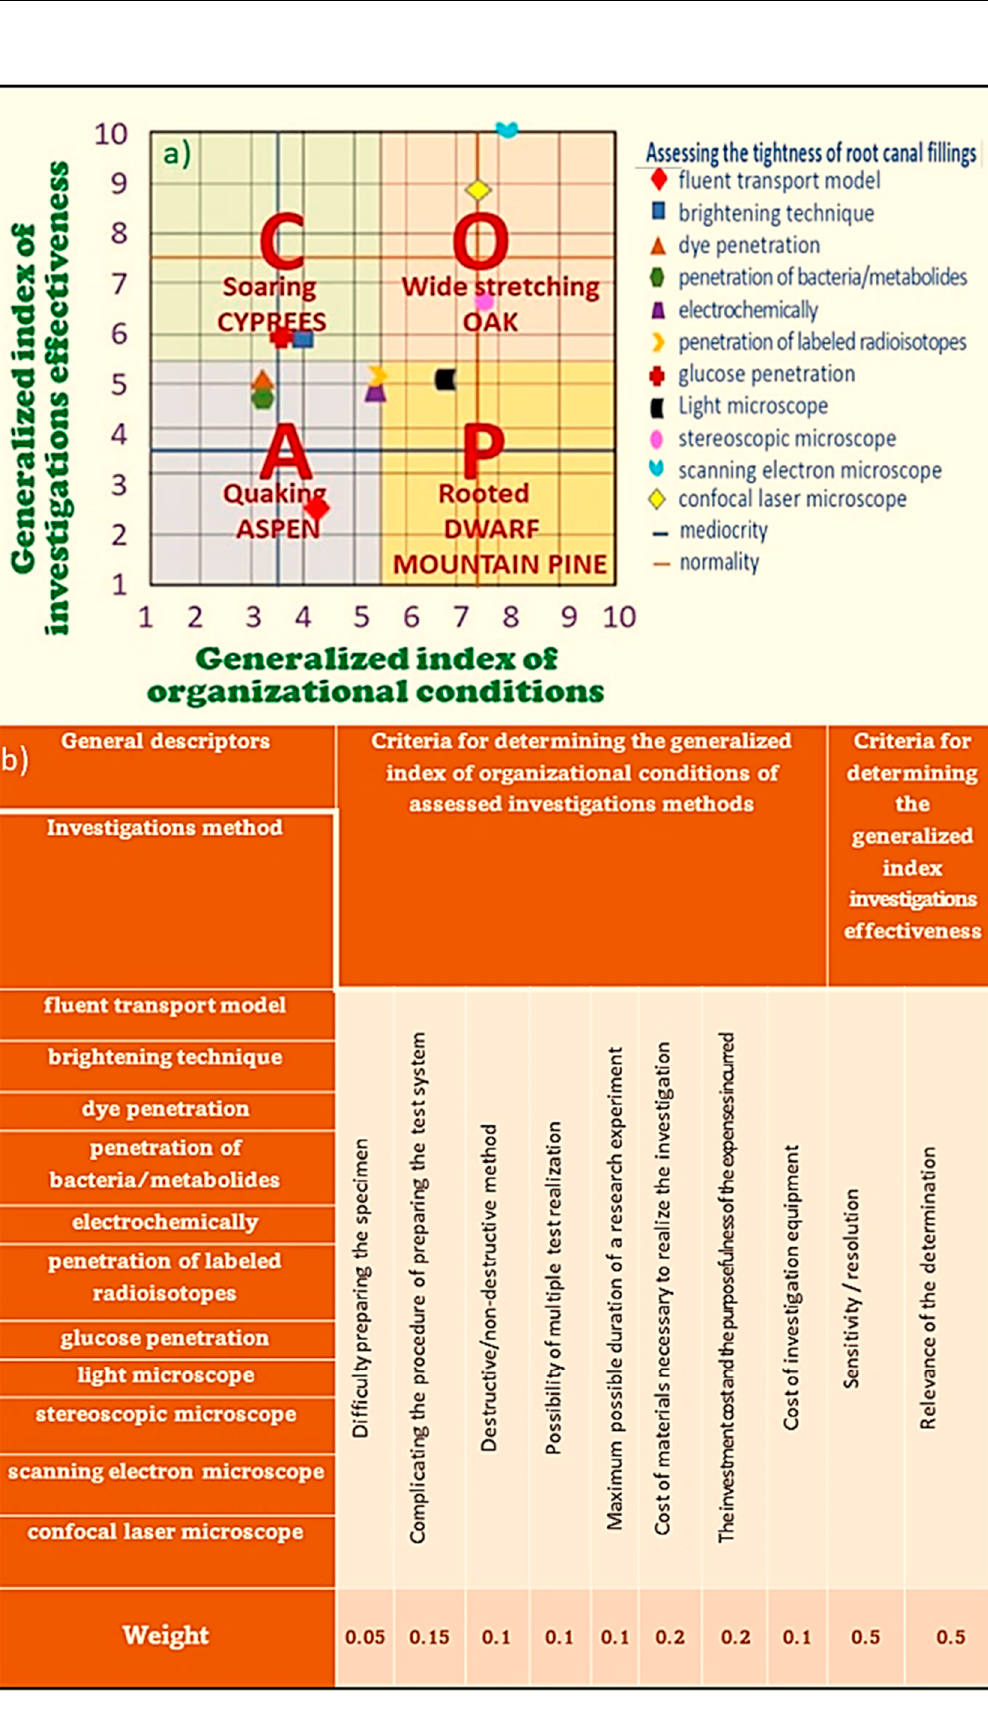
Figure 15. Contextual matrix of attractiveness ( a ) of the virtual contextual analysis regarding the selection of methods for assessing tightness of the root canal filling and a set of adopted criteria for expert assessment ( b ).